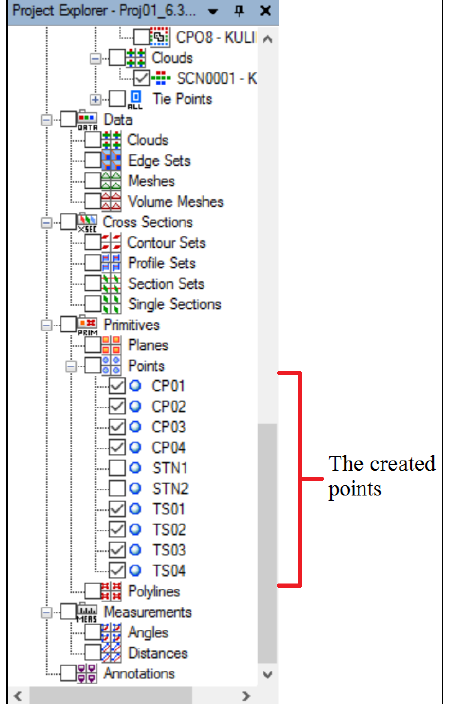
Figure 30. All the new points that was created appears in the Points folder